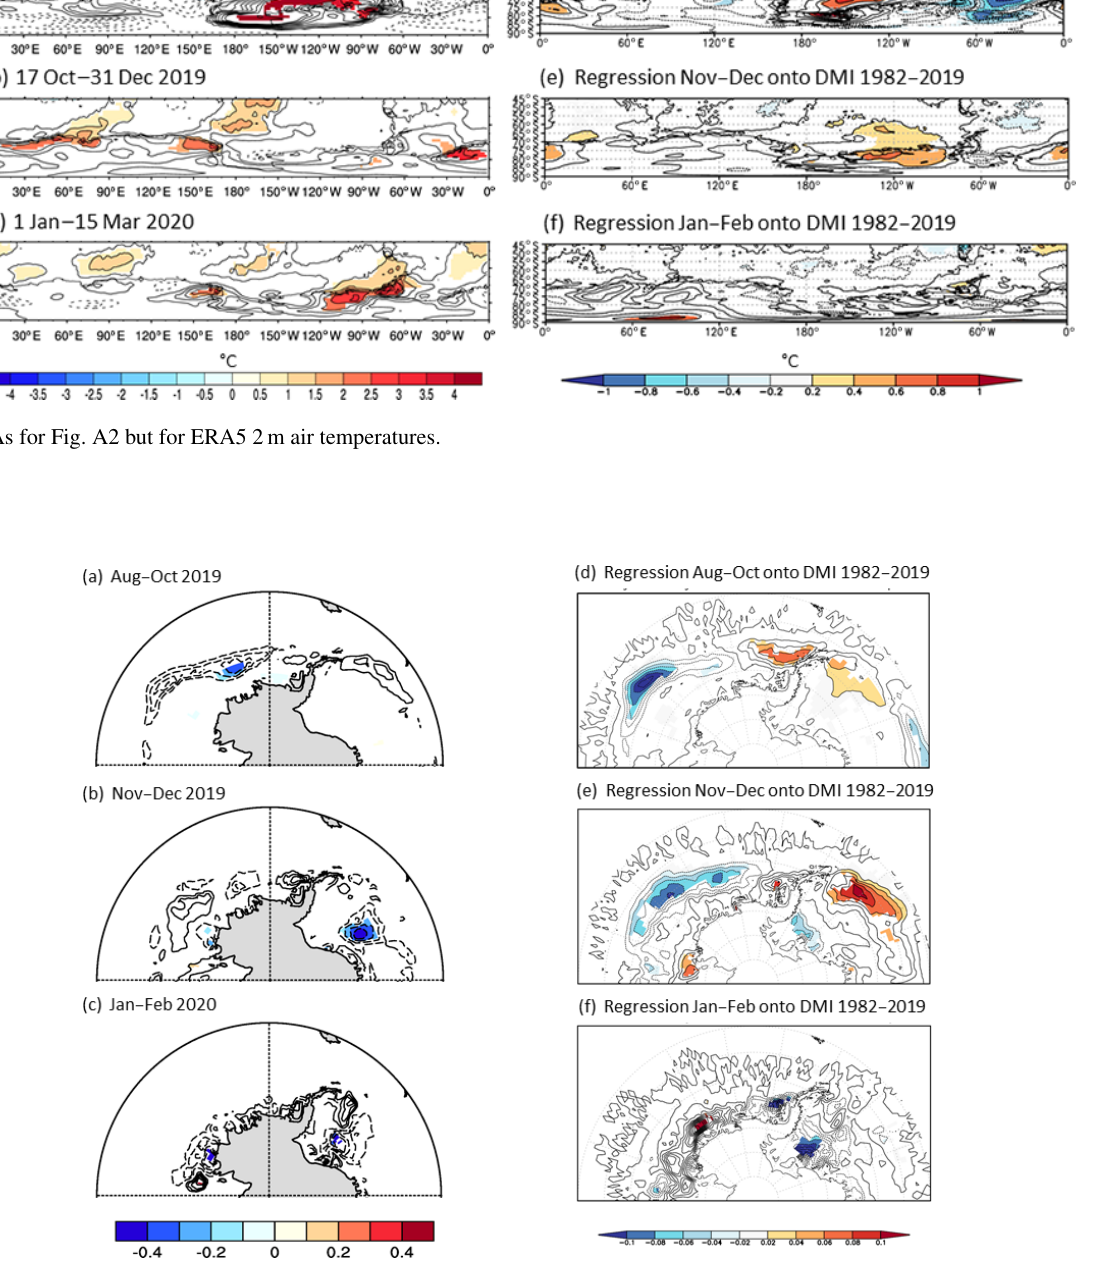
Figure A4. (a–c) Anomalies in sea ice concentration relative to the 1982–2019 climatological mean for (a) August, September, and October 2019; (b) November and December 2019; and (c) January and February 2020. Shading is as in Fig. A2. (d–f) Linear regression of sea ice concentration anomaly onto the Dipole Mode Index (DMI) for the equivalent period based on data from 1982 to 2019. Shading indicates regression is significant at p < 0 . 10. The regression coefficients are scaled by 1 standard deviation of the DMI so that the maps represent the anomaly that would be accounted for by 1 standard deviation in DMI for (d) August to October, (e) November to December, and (f) January to February. The regressions were computed using the Royal Netherlands Meteorological Institute (KNMI) Climate Explorer